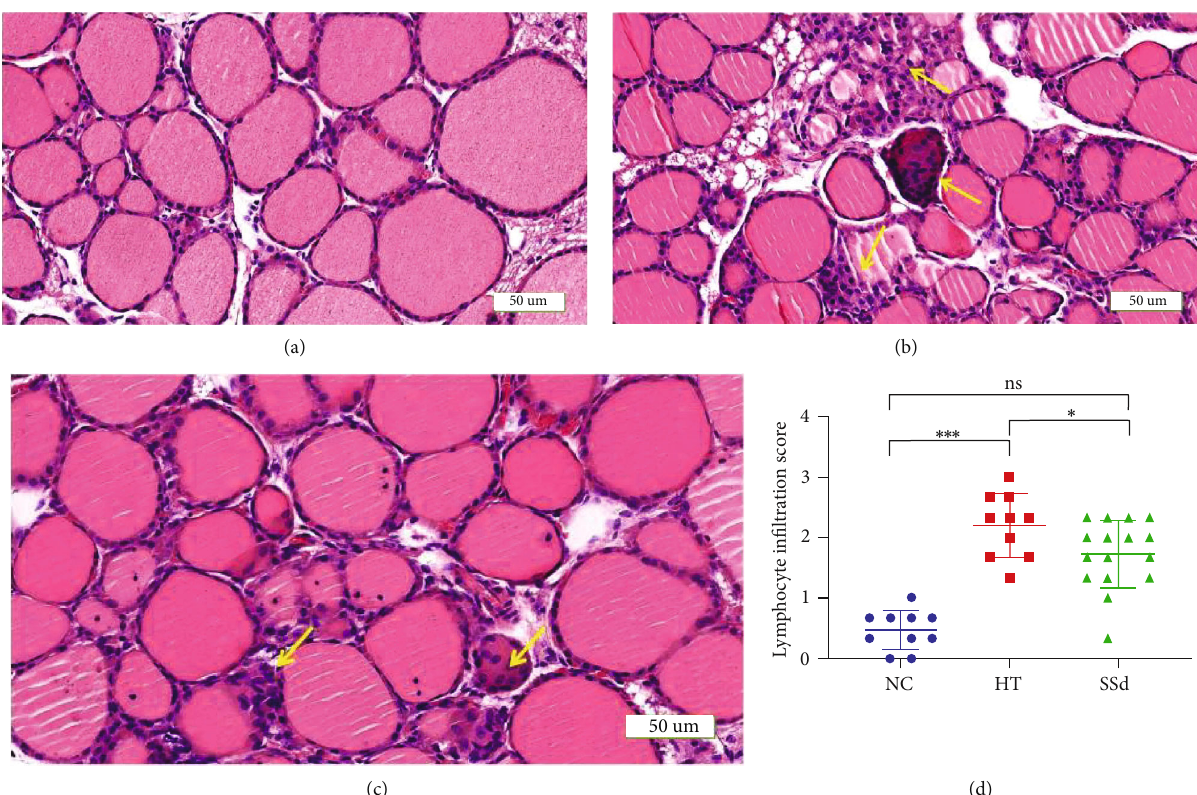
Figure 8: Thyroid lymphocyte in fi ltration in mice. (a) HE staining of thyroid tissue in the NC group mice (200x). (b) HE staining of thyroid tissue in the HT group mice (200x). (c) HE staining of thyroid tissue in the SSd group mice (200x). (d) Comparison of thyroid lymphocyte in fi ltration scores in mice ( ∗∗∗ P < 0 : 001 , ∗ P < 0 : 05 ). Lymphocytic in fi ltration is evident where the yellow arrow